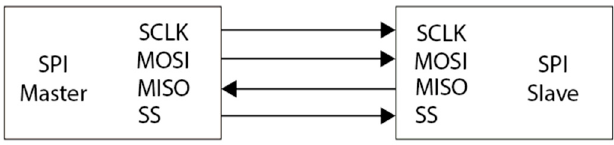
Figure 7. Serial peripheral interface (SPI) layout.